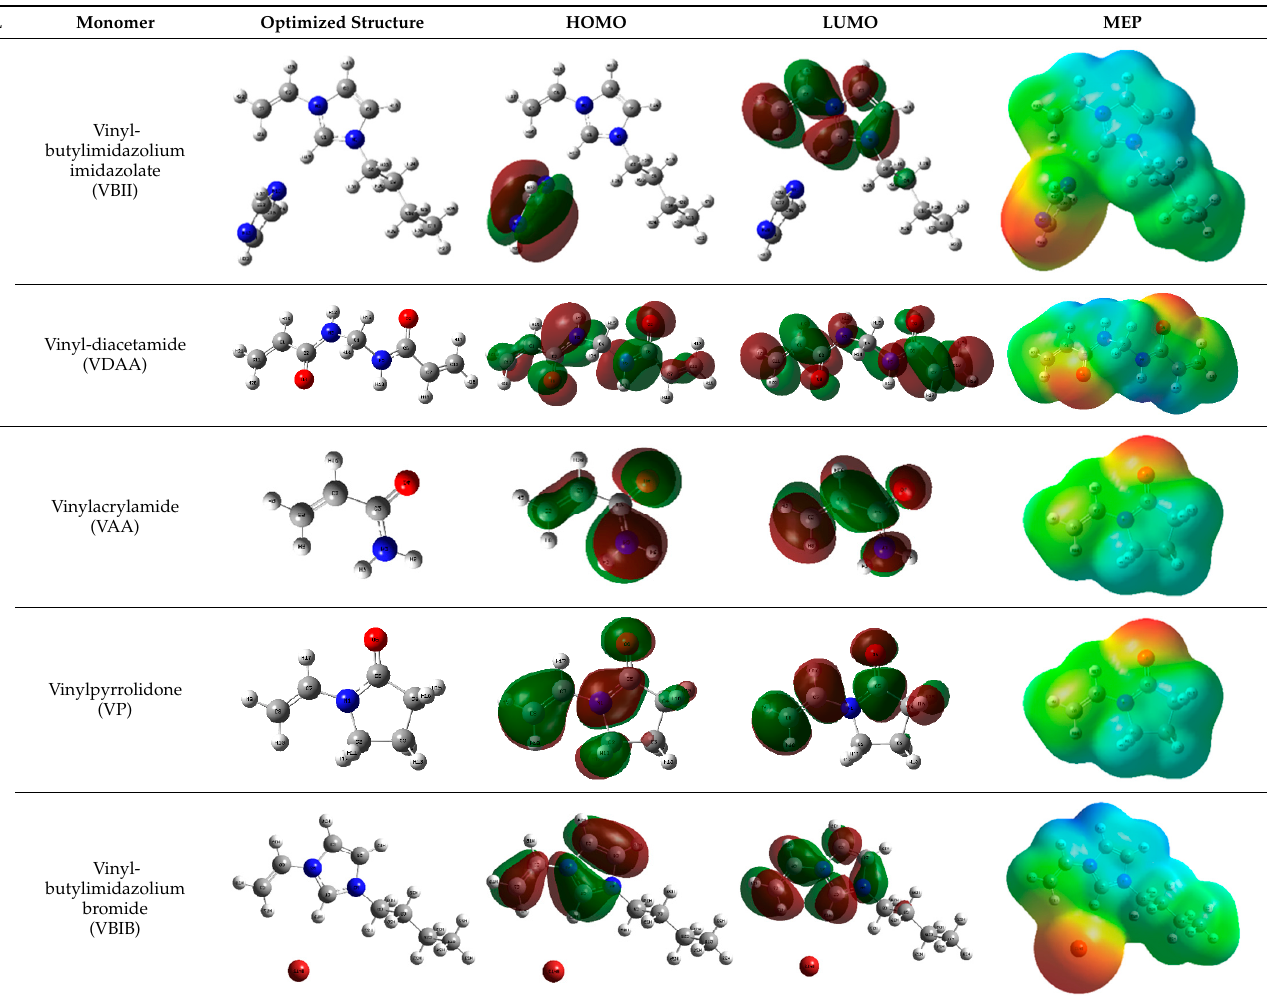
Table 7. Optimized structures, HOMO, LUMO and molecular electrostatic potential mapping of monomers obtained at the B3LYP/6-311++ theory level in aqueous medium.